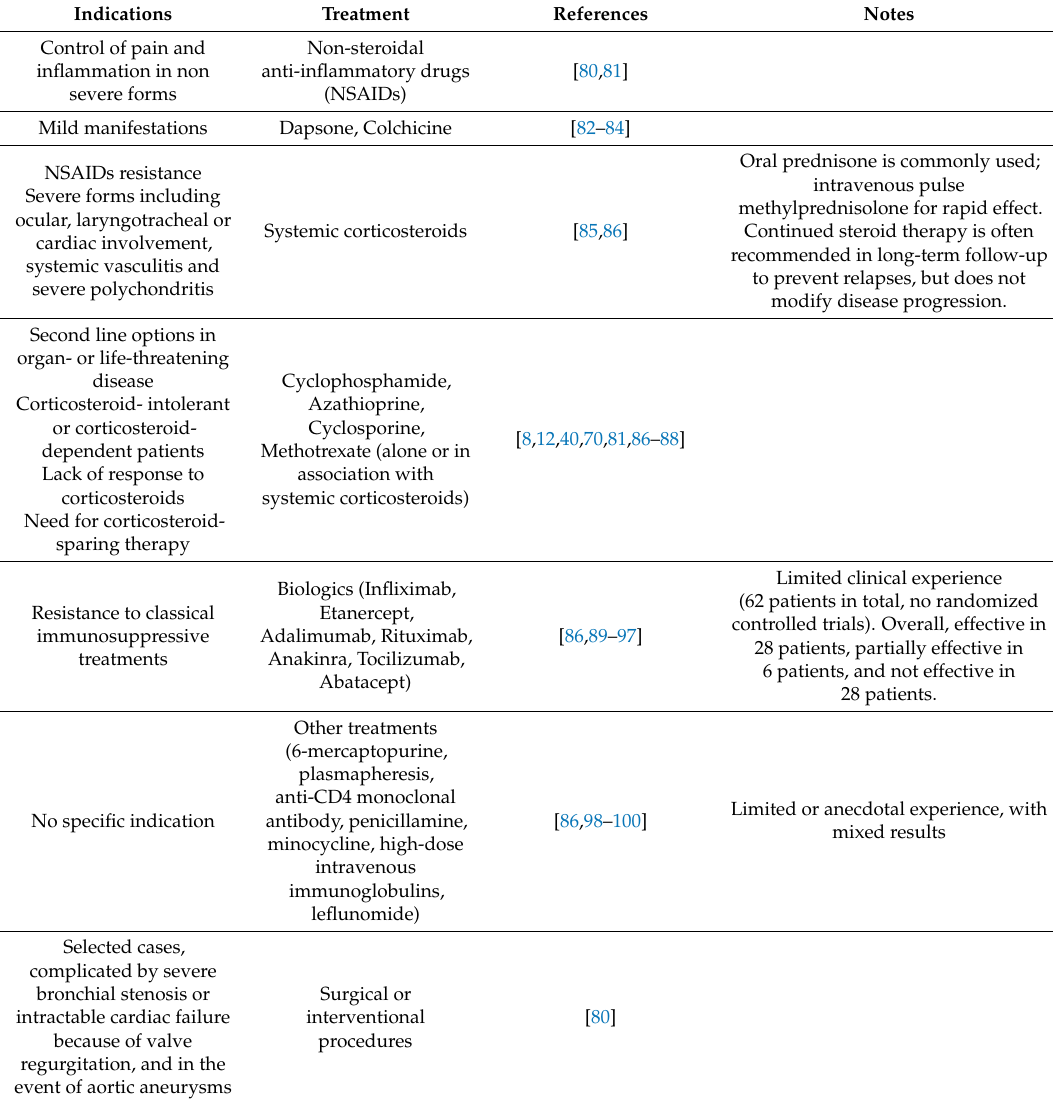
Table 2. Therapeutic options for relapsing